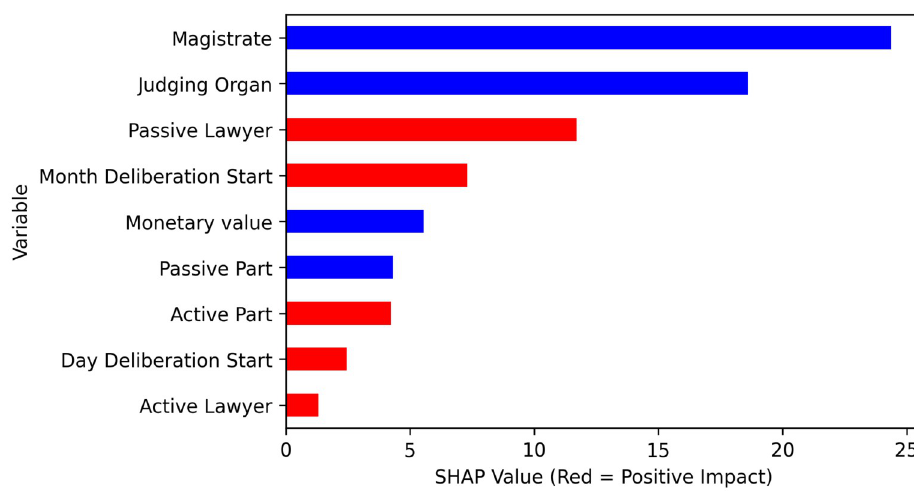
Fig 5. The correlation between the feature and the target of 300 random